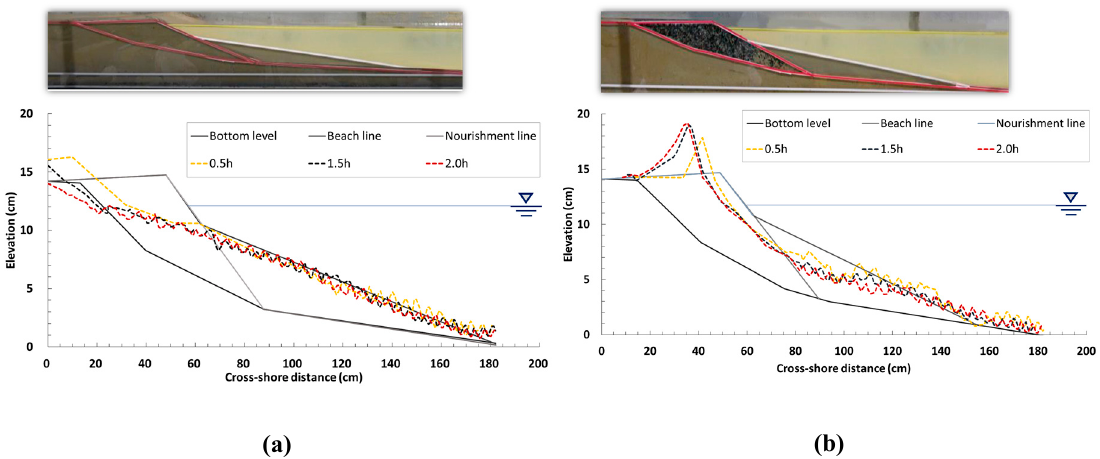
Figure 11. Experiment result of literature review; ( a ) d 50 : 0.16mm, ( b ) d 50 : 5mm.